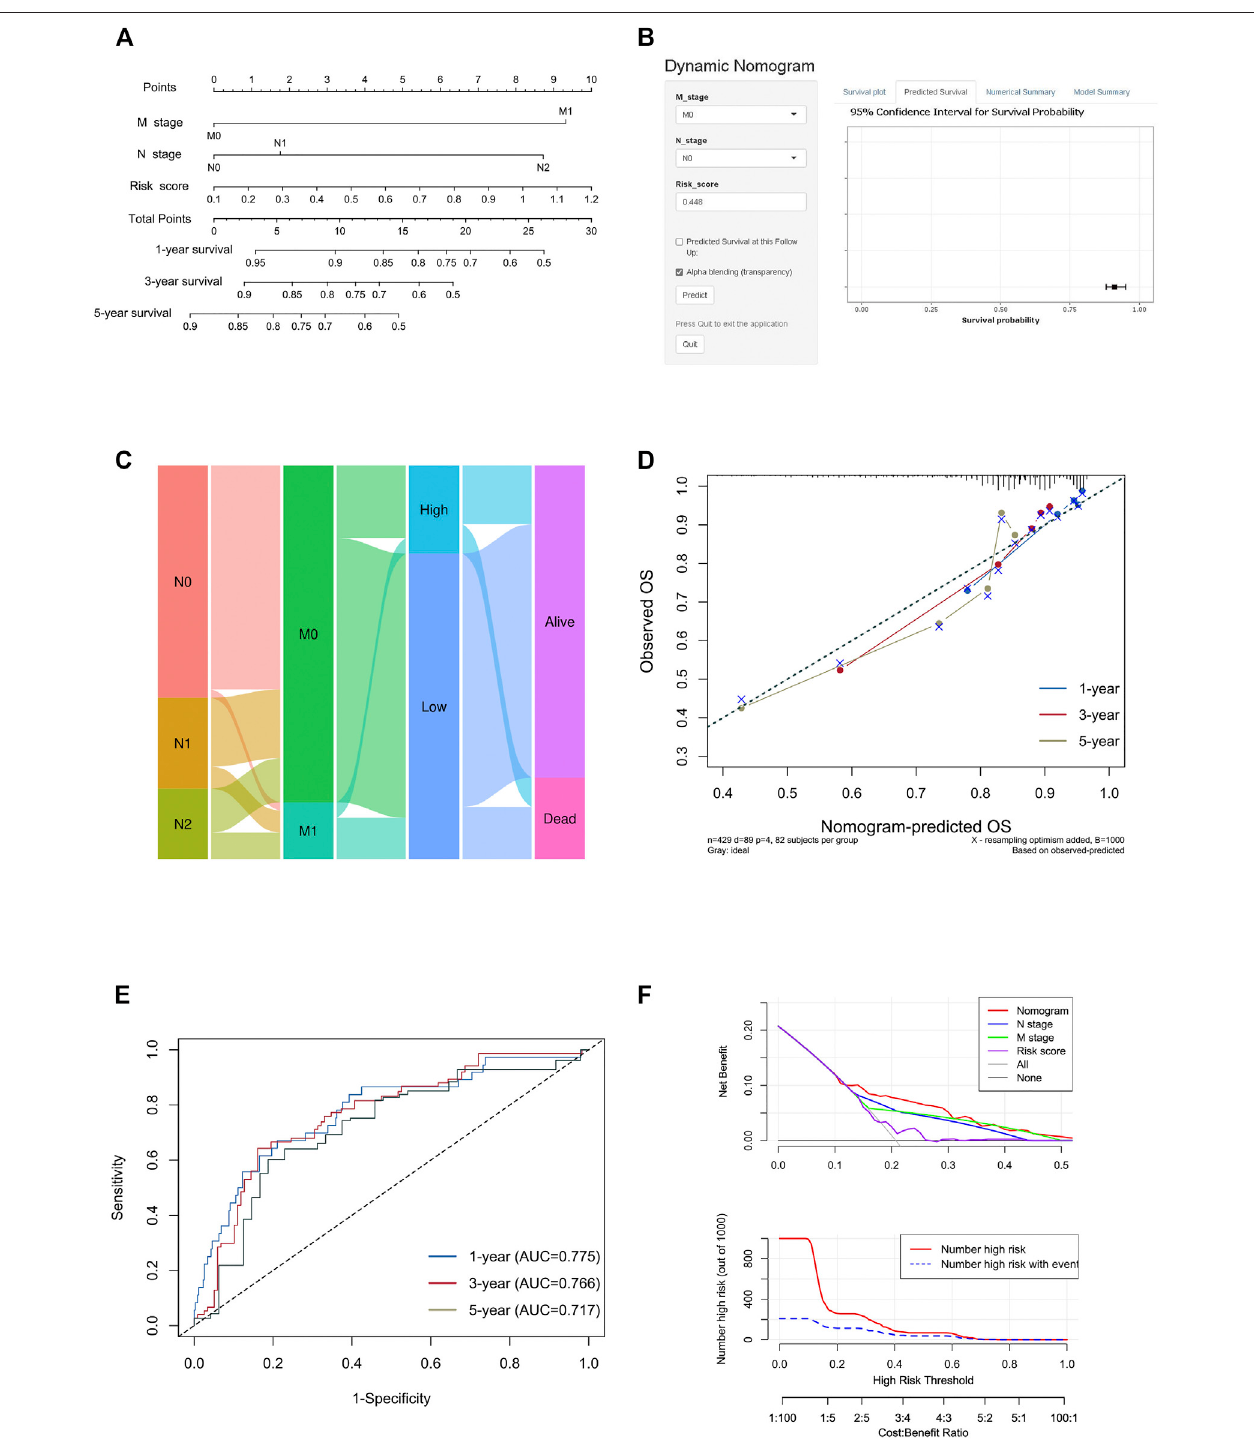
FIGURE9| Constructionandvalidationofthenomogrammodel. (A) Constructionofthenomogrammodelcombiningriskscoreandprognosticclinicopathological indicators in TCGA-COAD. (B) Online dynamic nomogram accessible at https://scxiangya.shinyapps.io/DynNom/, depicting an example for predicting the survival probability of apatient with TxN0M0 colon cancer and arisk score of 0.448. (C) Sankey diagram showing the distribution of patients in the high risk and low risk groups. (D) The calibration curve judging nomogram accuracy by comparing the relationship between predicted and observed overall survival. (E) Time dependent ROC curves showing the predictive ability of the nomogram. (F) Decision curve analysis curves and clinical impact curves evaluating the bene fi t when using the nomogram model.